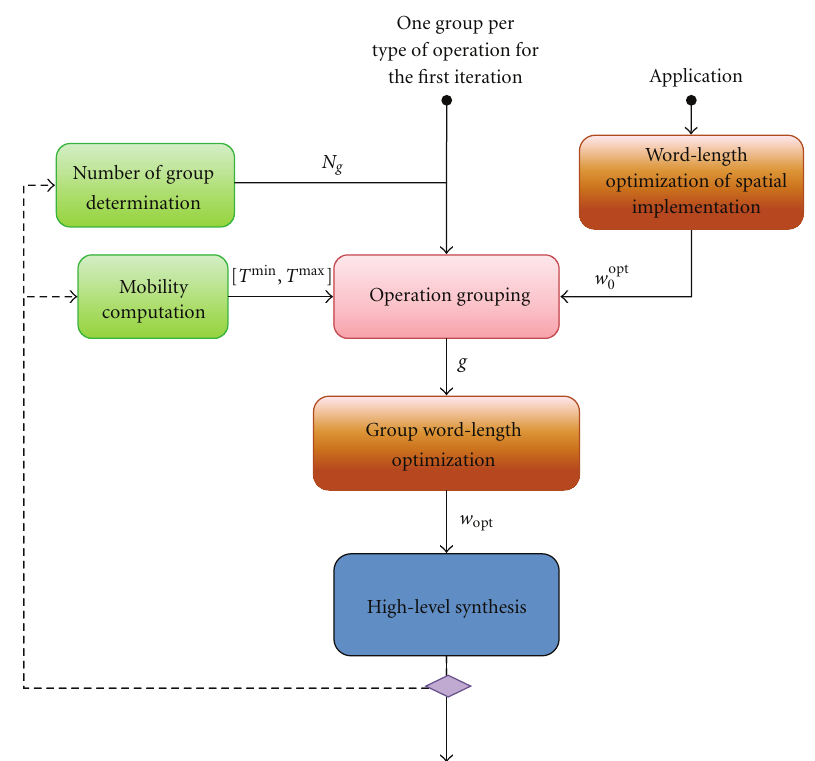
Figure 2: Iterative process for combining word-length optimization and high level